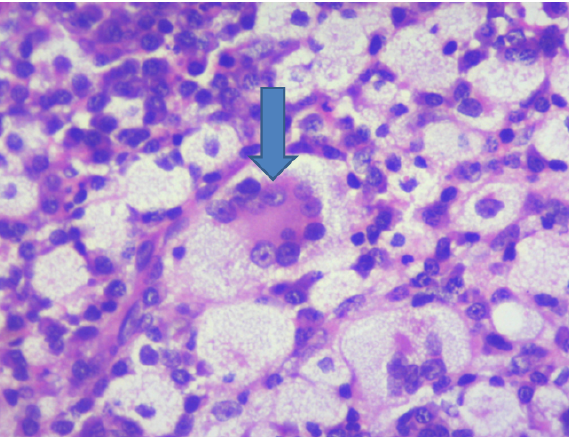
Figure 4: Histopathology showing Touton giant cell